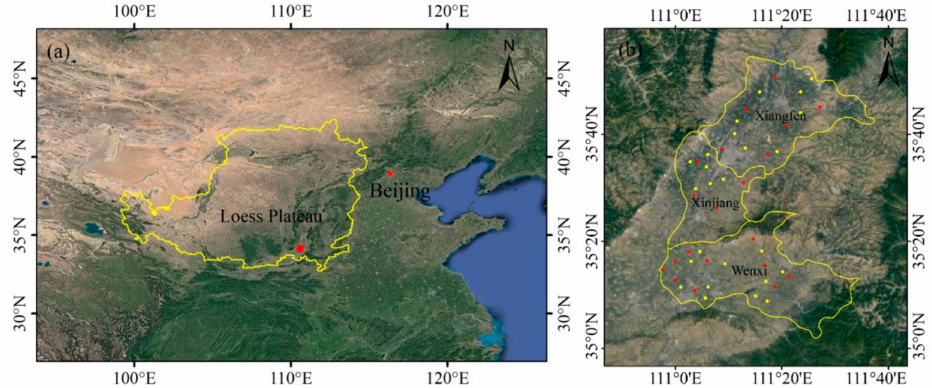
Figure 1. The geographical location and sampling sites of the study area. ( a ) The location of the study area in the Loess Plateau; ( b ) The location of the field measured points in the three counties. All points (including red and yellow points) are field measured points, and the red points are sampling sites for data